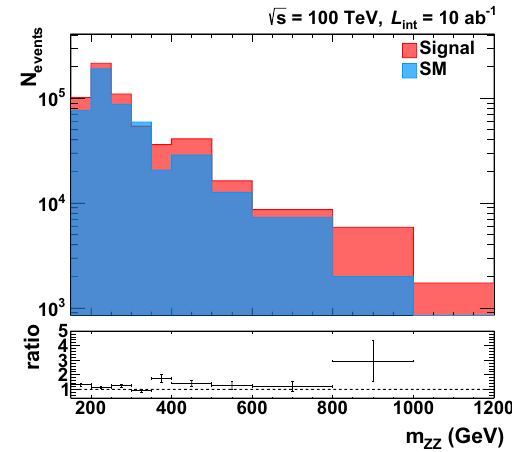
Fig. 9 Distributions of the reconstructed four-lepton invariant mass m ZZ . In the m ZZ distribution, the bin contents are normalized to the bin widths. The lower plot shows the ratio of signal and background in the bins. The error bars in the x -axis represent the variable bin size in the mass. The error bars in the y -axis represents the statistical error in each bin